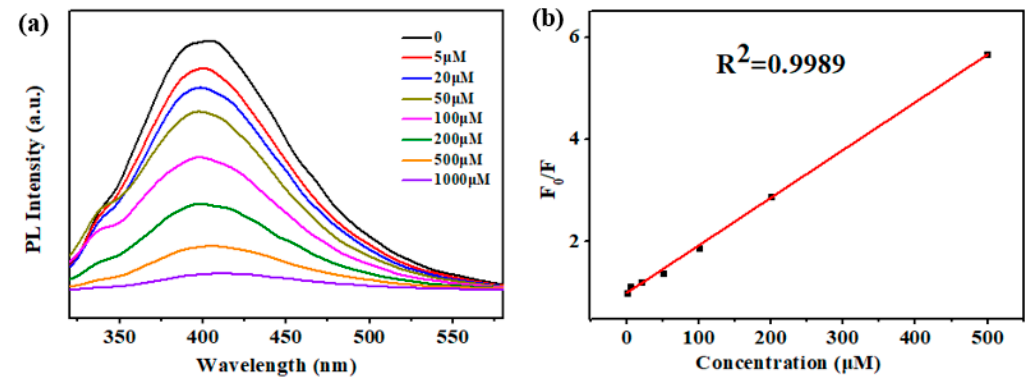
Figure 6. ( a ) Fluorescent emission spectra of N-L-CQDs quenched by Fe 3+ with various concentrations (from top to bottom: 0, 5, 20, 50, 100, 200, 500, and 1000 μ M) in river water. ( b ) A linear relationship of F 0 / F on the concentration of Fe 3+ ranging from 0 to 500 μ M).